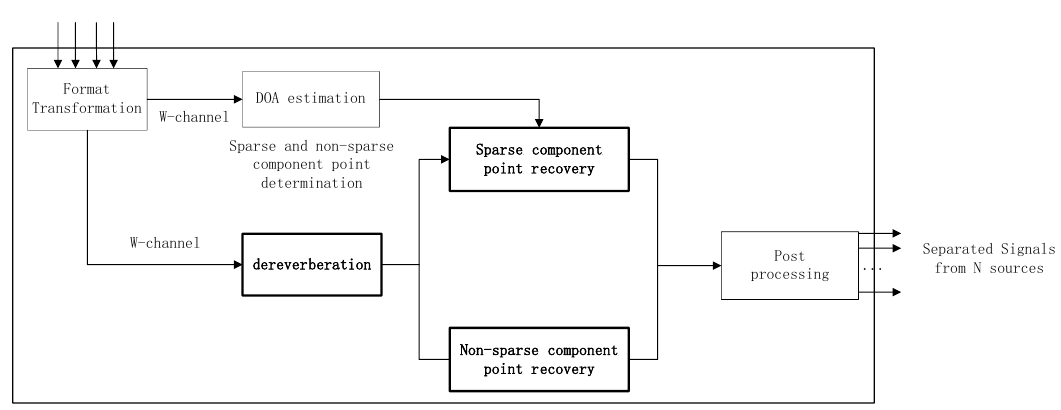
Figure 1. Schematic diagram for the proposed method for multi-source separation.